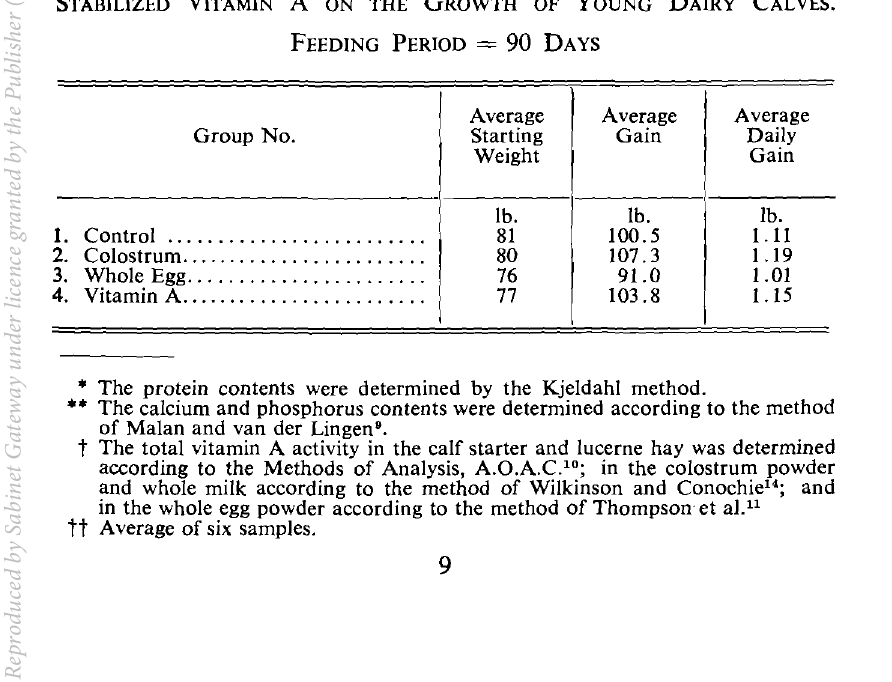
rotein (N. X 6.25)%* p